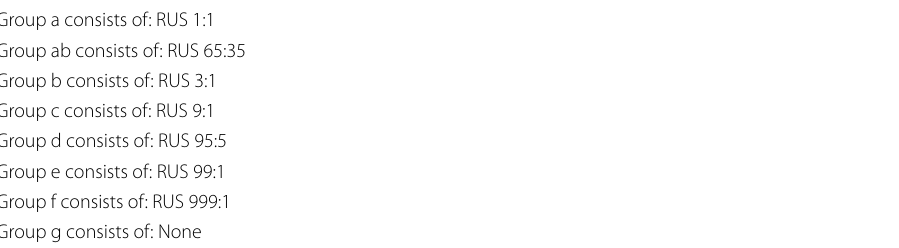
Table 22 HSD groupings of sampling ratios after 2-factor ANOVA where classifier and sampling ratio are factors with SQL Injection web attacks; groups are by performance in terms of